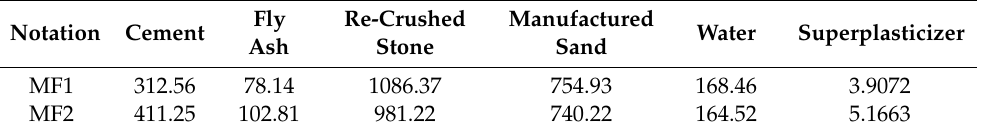
Table 4. Mix proportions of concrete (kg/m 3 ).